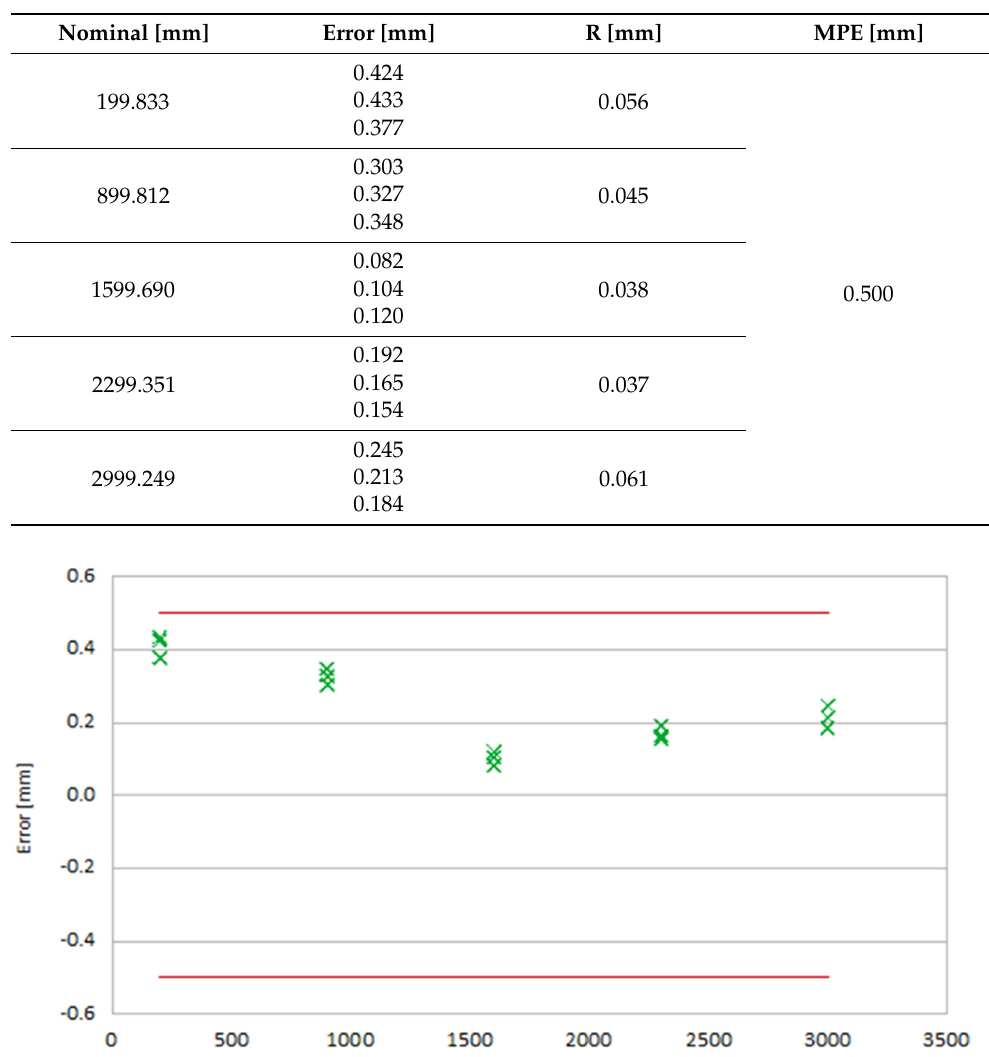
Table 5. Measurement errors of the XZ2 axis.